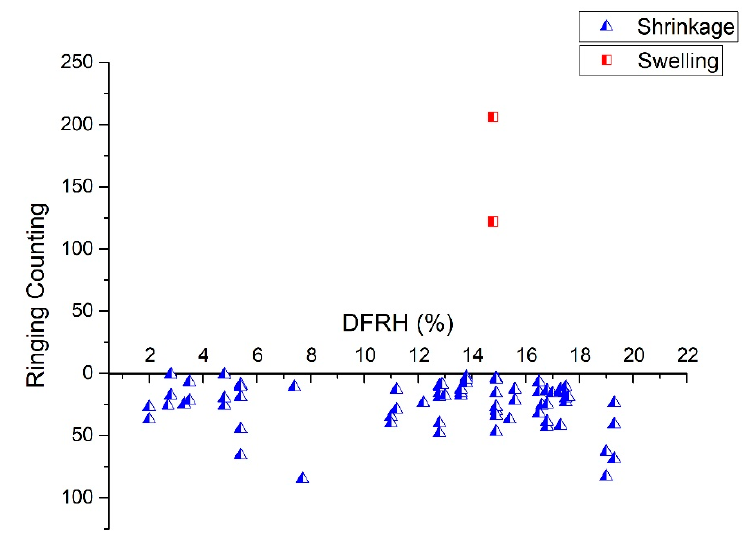
Figure 15. AE activity of ancient wood under the condition of shrinkage and swelling.